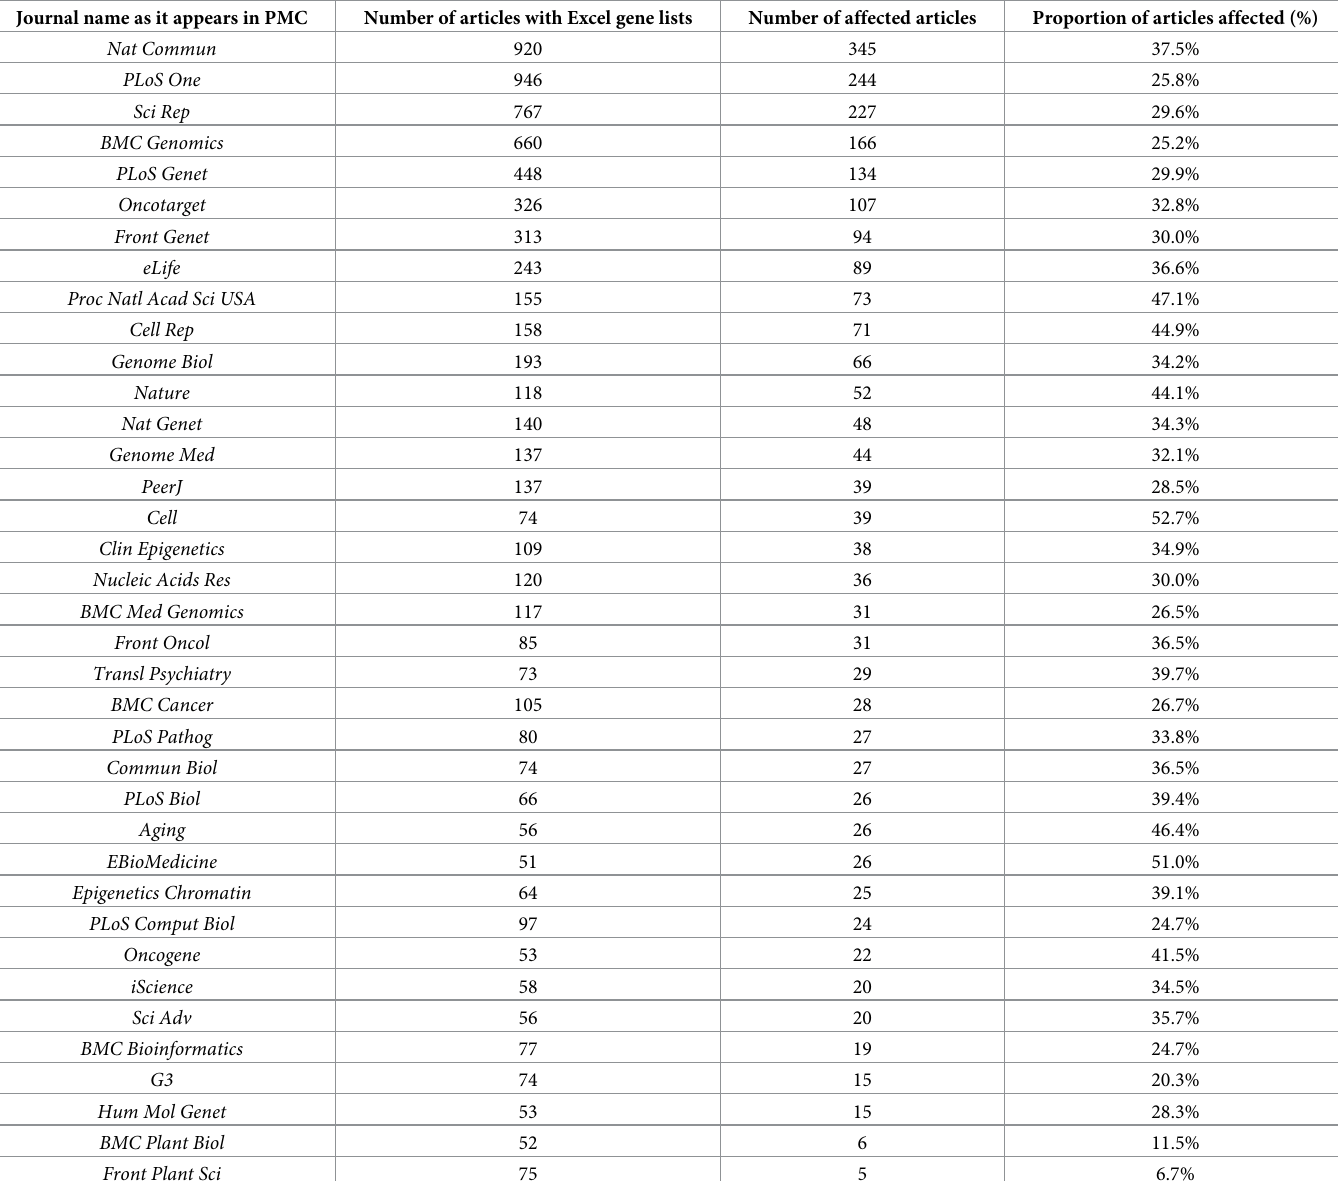
Table 5. Prevalence of gene name errors across journals. Only journals with � 50 articles with supplementary Excel gene lists are